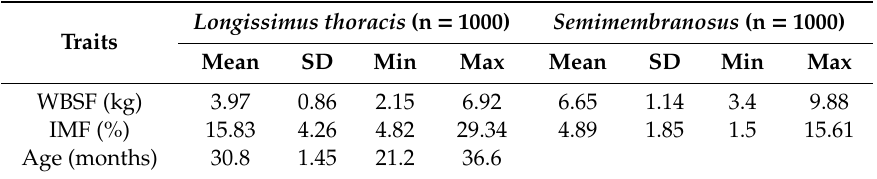
Table 1. Summary statistics of Warner-Bratzler shear force (WBSF), intra-muscular fat (IMF), and age at slaughter in Longissimus thoracis and Semimembranosus muscle of